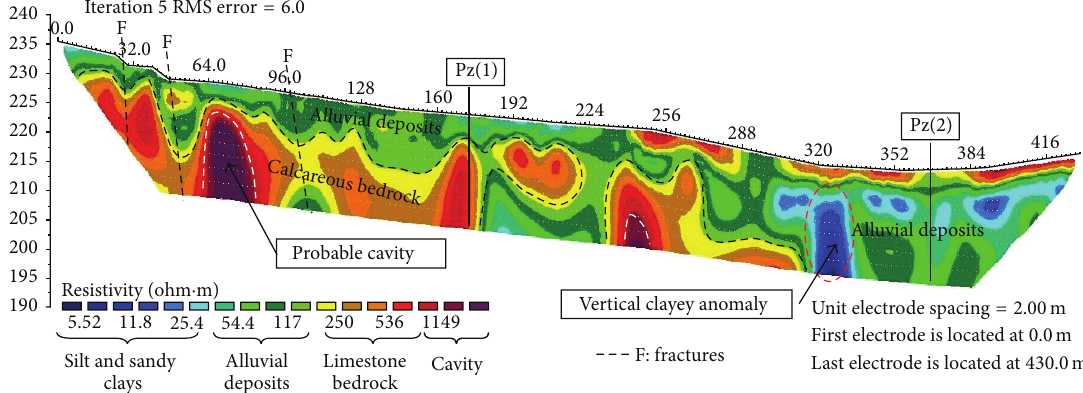
Figure 6: Interpretation of the geoelectrical section of the ERT-P2 profile carried out in upstream of Abu Baara dam, where Pz(1) and Pz(2) are piezometric